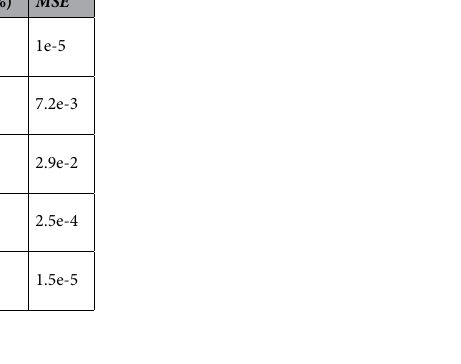
Table 1. Comparison of the